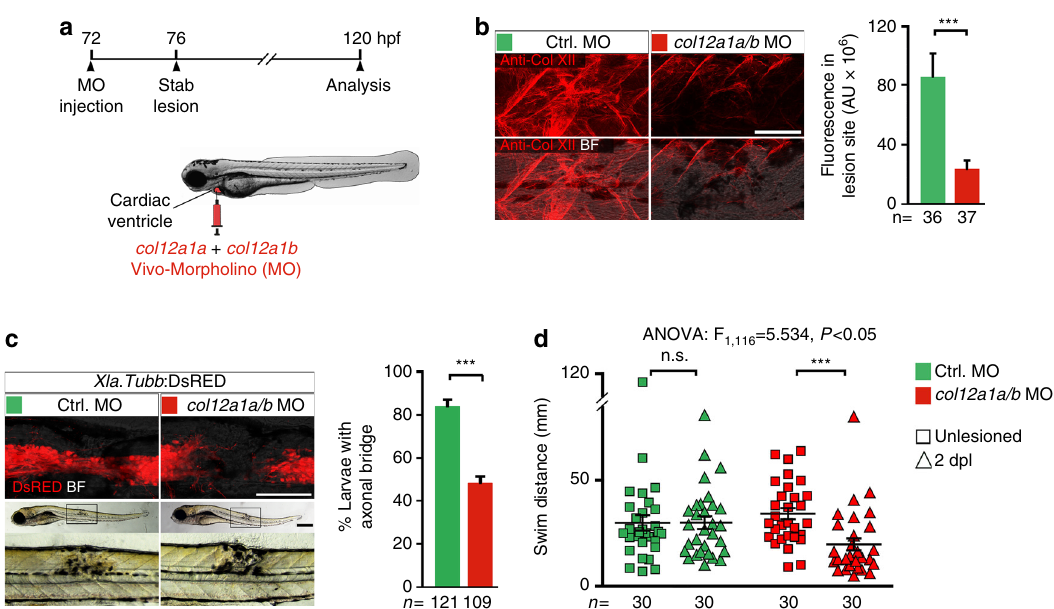
Fig. 5 Knockdown of col12a1a/b inhibits functional axon regeneration. a Cartoon showing strategy used for systemic delivery of Vivo-Morpholino (MO), which acts as cell-permeable translation blocking anti-sense molecules. MOs against col12a1a and col12a1b were co-injected into the cardiac ventricle at 3 dpf, 4 h before lesion. b col12a1a/b MO injection strongly reduces Col XII immunoreactivity in the lesion site compared to control MO injected animals. ( t -test: *** P < 0.001). c col12a1a/b MO injection inhibits axon regeneration after lesion (Fischer ’ s exact test: *** P < 0.001). d col12a1a/b MO injection interferes with functional recovery after lesion (two-way ANOVA: F 1,116 = 5.534, p < 0.05; t -test: *** P < 0.001). a – d Lateral views are shown (dorsal is up , rostral is left ). BF: bright fi eld. n.s.: not signi fi cant. Scale bars : 200 µ m c and 100 µ m ( b , c ). Error bars indicate